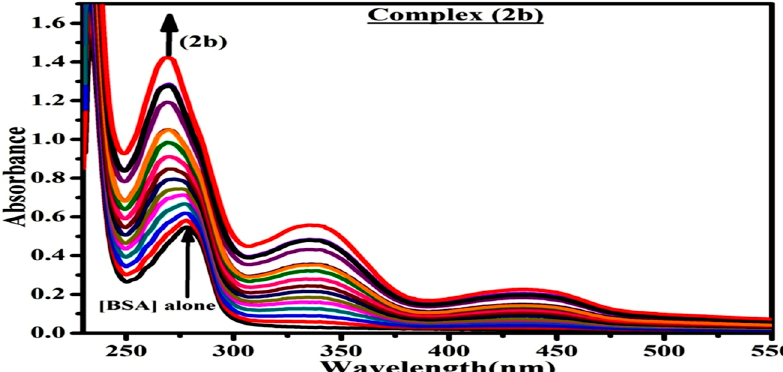
Figure 7. The absorption spectra of BSA alone and in the presence of increasing amount of ligand ( HL ) and complexes ( 1b – 2b ) in Tris-HCl buffer pH = 7.2 at 25 °C. The arrow indicates the changes in absorbance upon increasing the compound concentration. Table 7. The absorption spectral parameters of ligand ( HL ) and its complexes ( 1b–2b ) bound to BSA.